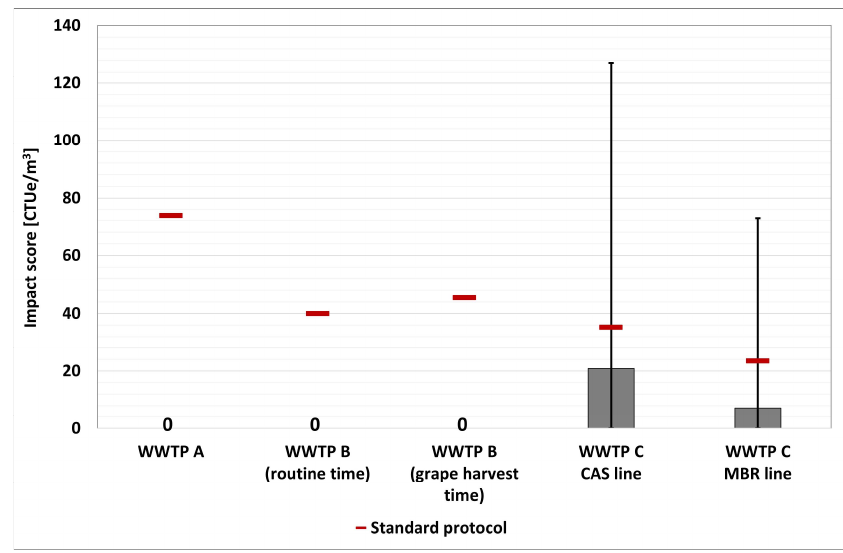
Figure 4. Environmental footprint related to the freshwater ecotoxicity calculated with the alterative protocol starting from the outcomes of the A. cepa test. “0” indicates that the impact score is nil. The red stroke represents the conventional impact score calculated without considering the substances detected above the LOQ.